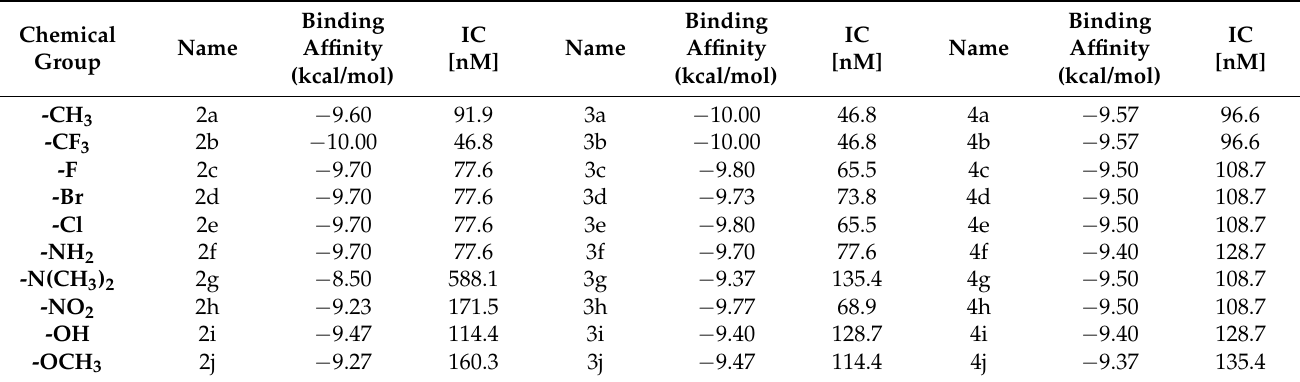
Table 2. The values of biding affinity and inhibition constants (IC) of 5-nitroisatin-based benzoylhy- drazines towards CDK2 active